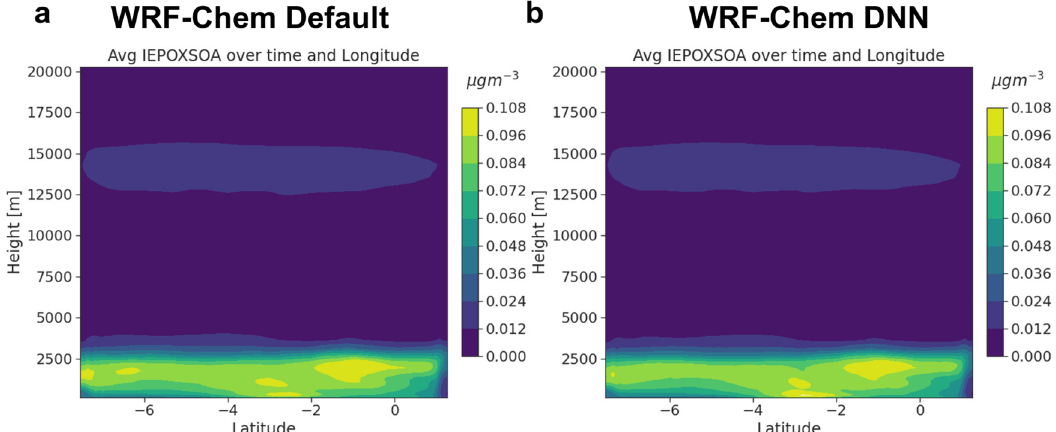
Fig. 4 WRF-Chem default and WRF-Chem DNN predictions of zonal and time-averaged IEPOX-SOA concentrations. Total IEPOX-SOA (summed across all size bins) and averaged across six days, including Sep 23 – 28 2014 over the Amazon ( a ) WRF-Chem Default and ( b ) WRF- Chem DNN. WRF-Chem DNN shows excellent agreement with WRF-Chem Default near surface and in the upper troposphere where IEPOX- SOA concentrations are signi fi